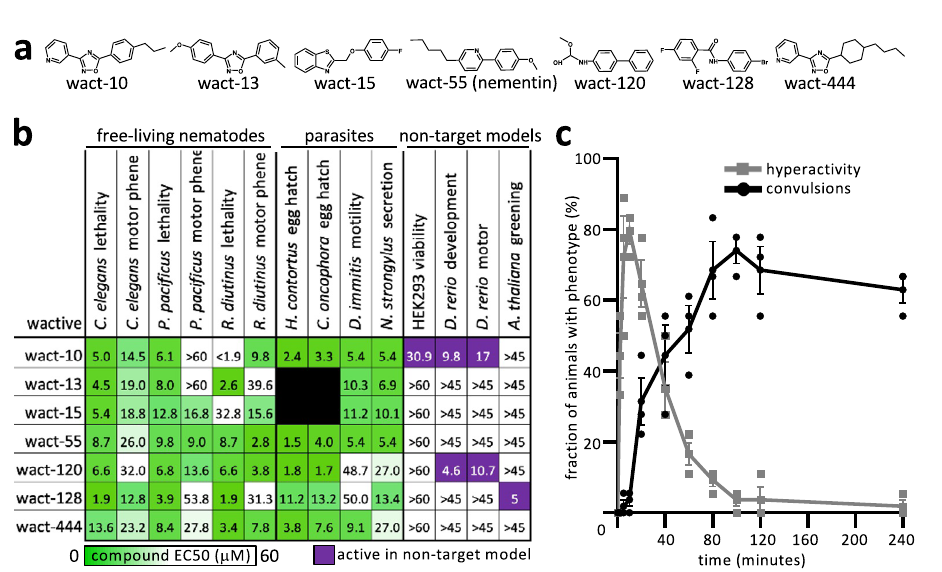
Fig. 3 The motor-centric approach yields convulsion-inducing nementin-1. a Structures of the seven prioritized neuromodulators. b Bioactivity of the seven prioritized molecules. Data are EC50s (details of assays are provided in the methods) except for the A. thaliana greening assay, which is the lowest concentration that yields a discernible difference from control in at least two of the three biological replicates tested ( n = 3). c A time-course analysis of 60 µ M nementin-1-induced locomotory phenotypes. Data are the mean of biological triplicate measurement of 18 animals per each time point over three biologically independent replicates ( n = 3). The SEM is shown. Primary data for this fi gure can be found in Supplementary Data